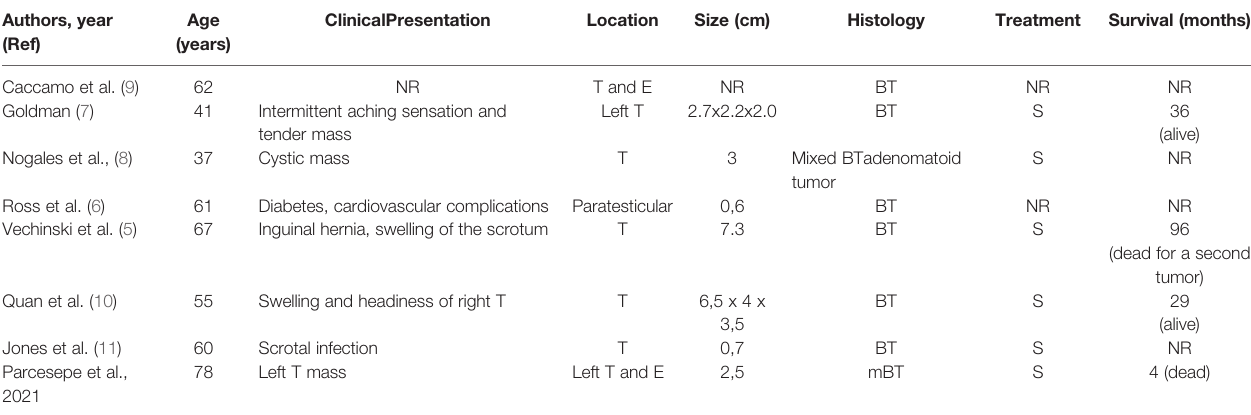
TABLE 2 | Overview on Testicular/paratesticular and epididymal BT published in